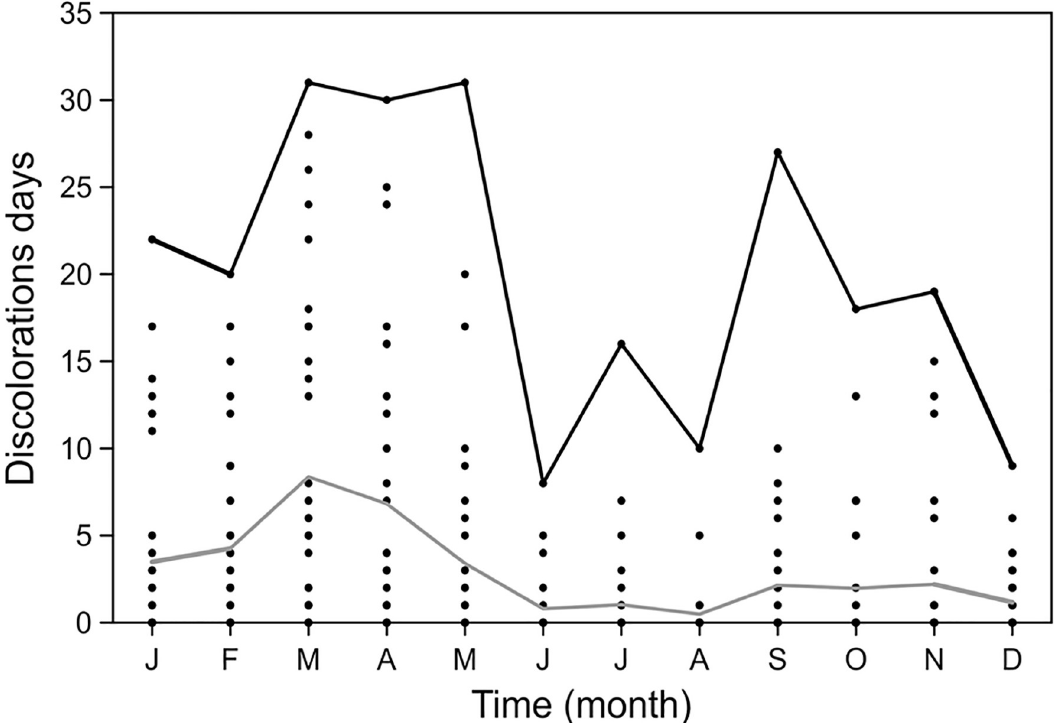
Fig 5. Monthly discoloration days (dots), the upper black line represents the maximum monthly values while the gray line is the normal year.